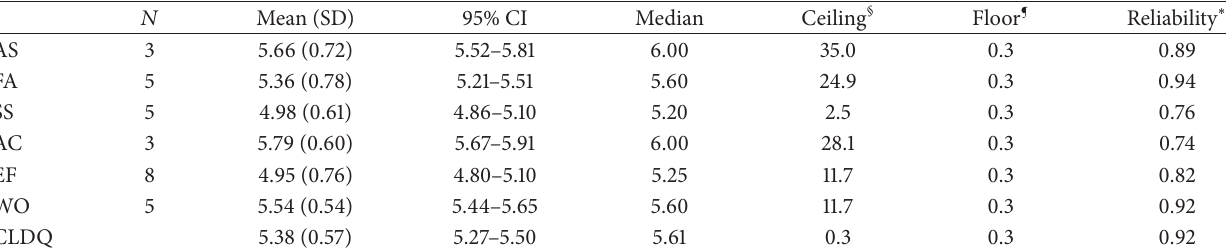
Table 2: Central tendency, variability, and reliability of the CLDQ scales.